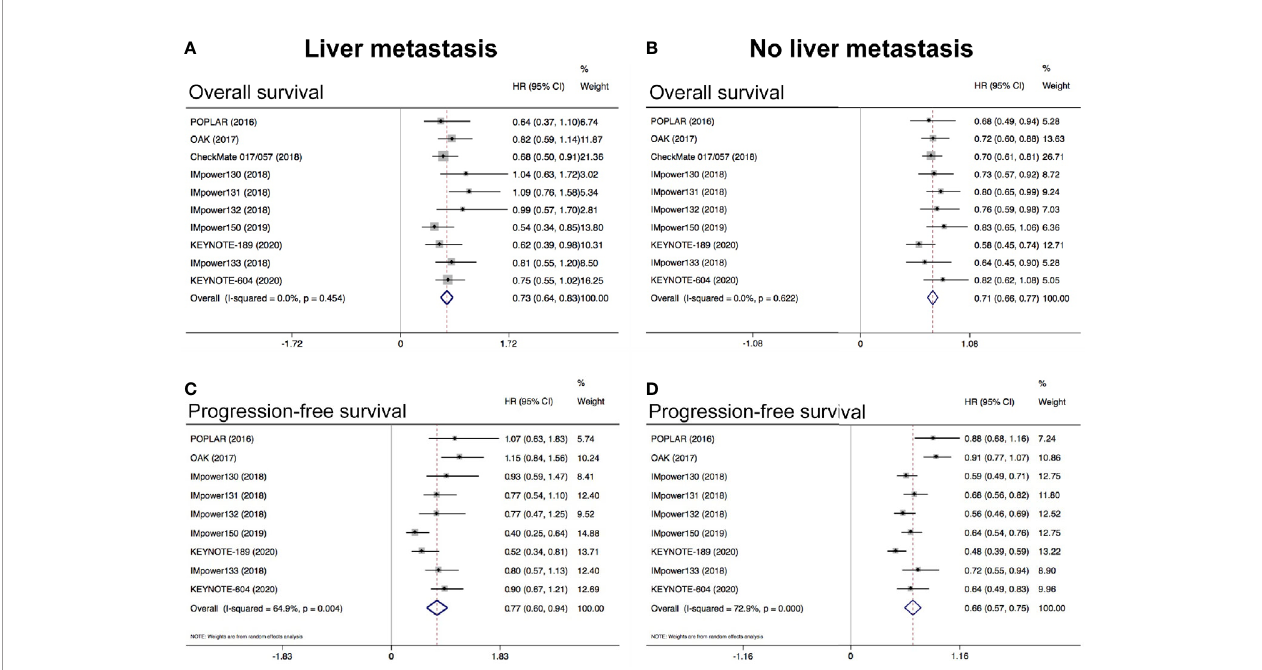
FIGURE 3 | Meta-analysis to evaluate the predictive value of LM in NSCLC treated with ICIs. (A) Pooled analysis of OS in patients with LM; (B) Pooled analysis of OS in patients without LM; (C) Pooled analysis of PFS in patients with LM; (D) Pooled analysis of PFS in patients without LM. LM, liver